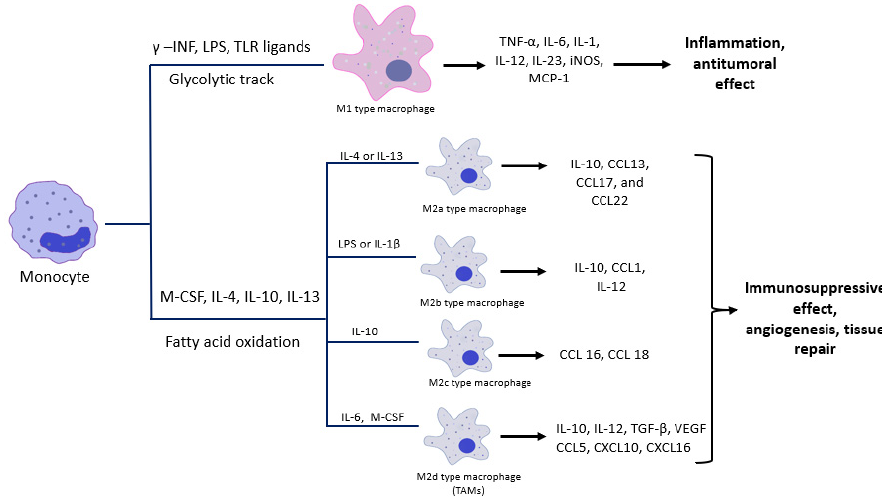
Figure 1. The classical (M1) and the alternative (M2) macrophage activation and their effect on the involved tissues.